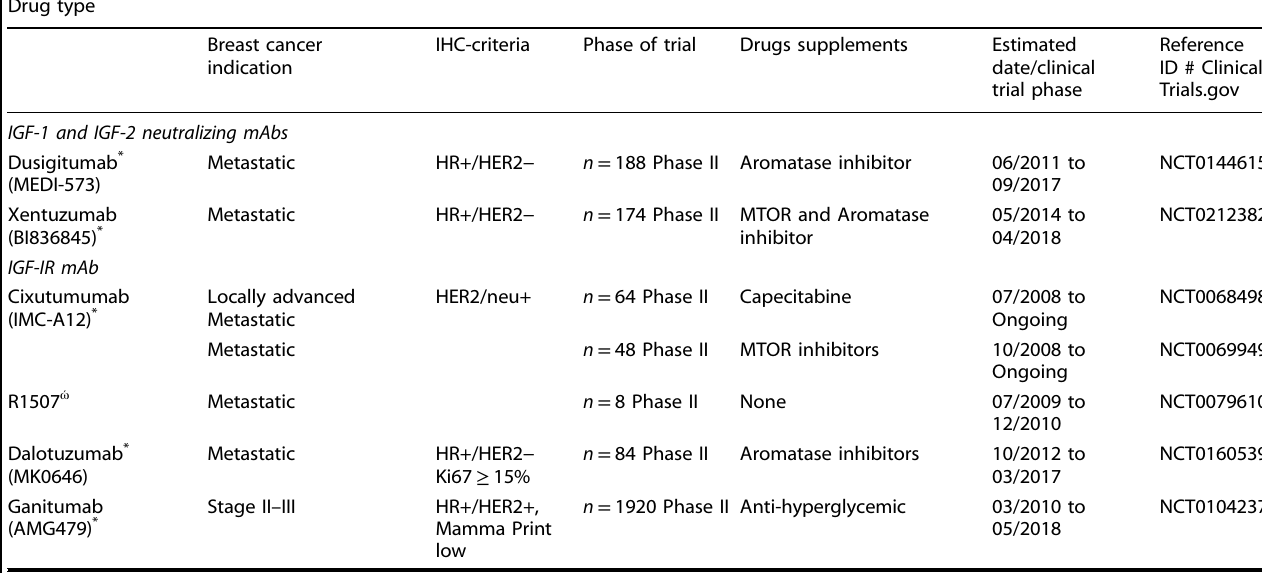
Table 1. Current potential anti-IGFs and IGF-1R mAb in breast cancer trials Drug